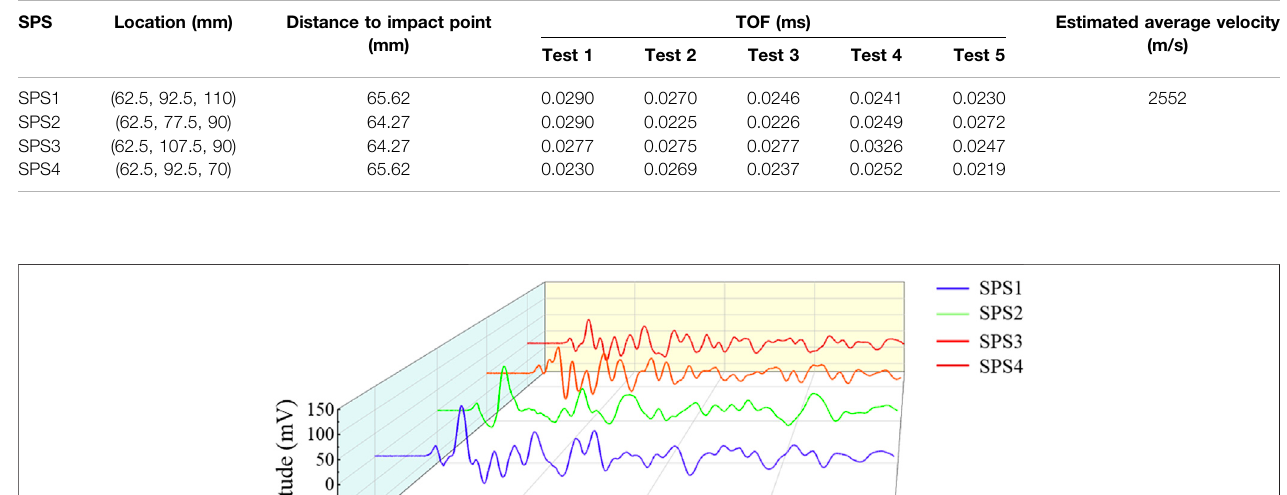
TABLE 2 | Estimation of the stress wave velocity.